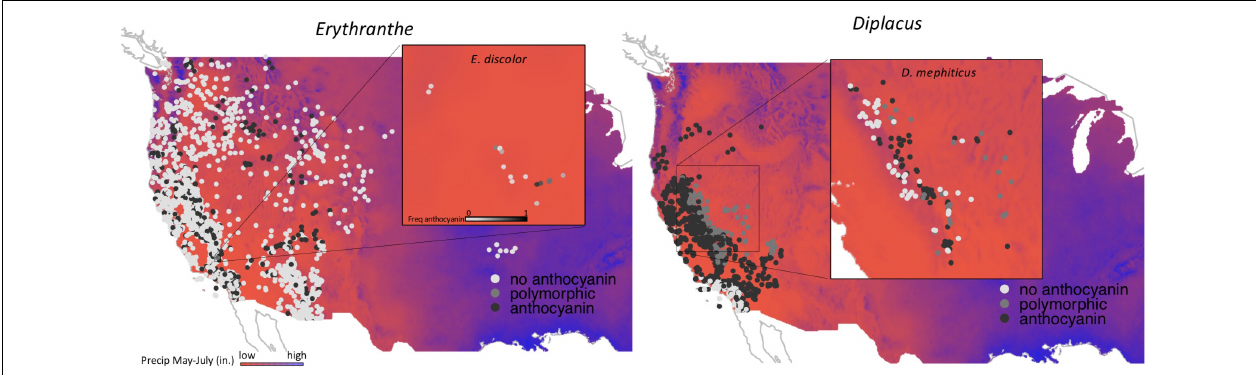
FIGURE 2 | Occurrence data for Erythranthe (left panel) and Diplacus (right panel) with filled circle color representing anthocyanin pigmentation (see legend). Background colors represent precipitation during peak flowering with red indicating regions with the lowest precipitation and blue indicating the highest. Insets represent population level data for the two focal species that are polymorphic for flower